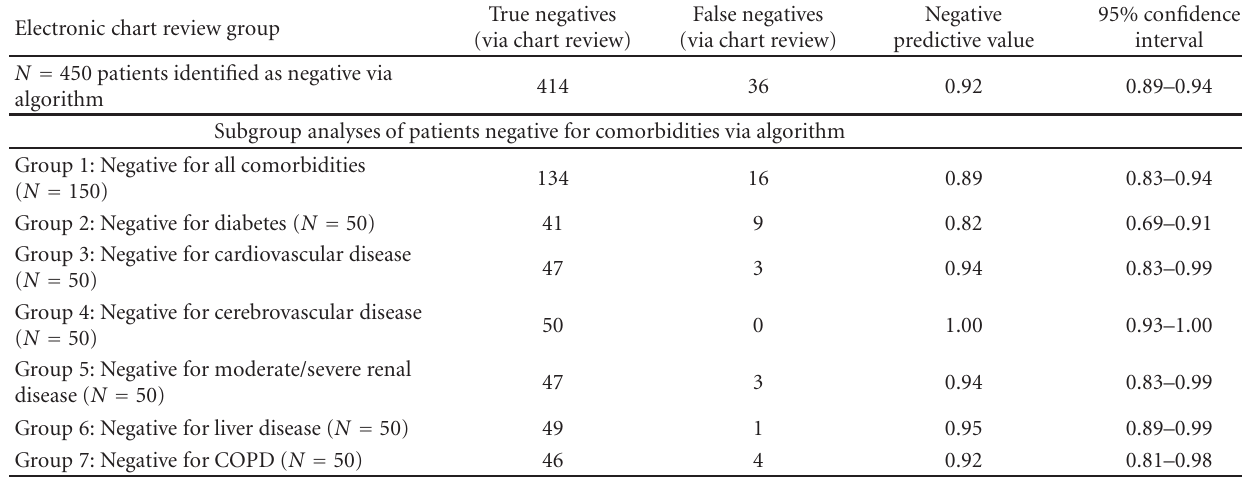
Table 2: Measured reliability of algorithm (combination of programmatic queries and key word